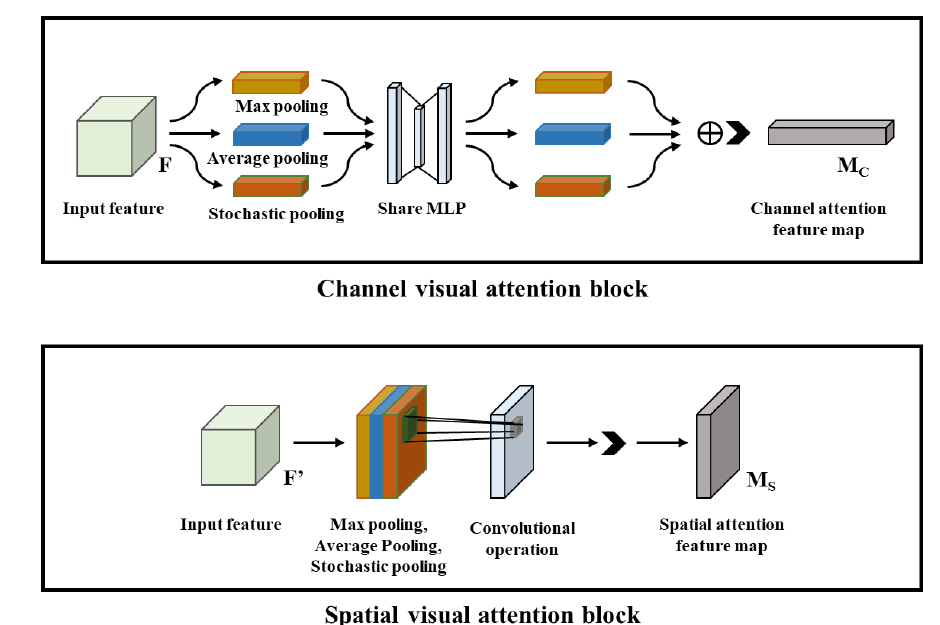
Figure 5. Structure of the proposed channel attention block and spatial attention